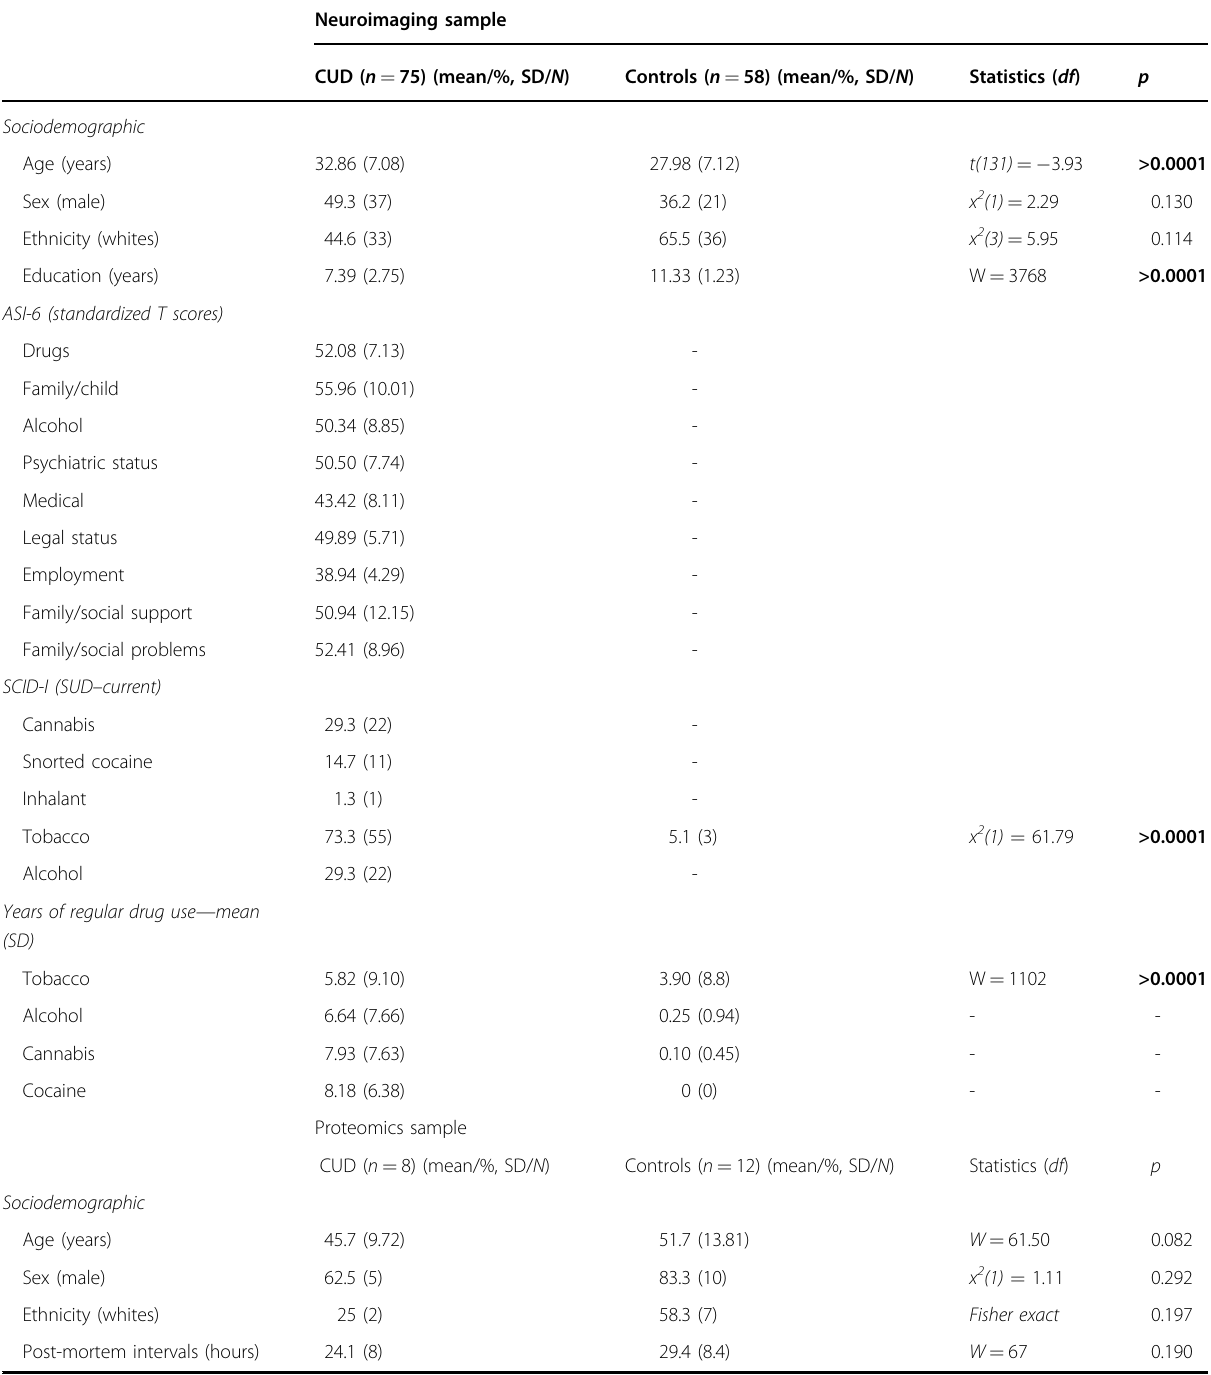
Table 1 Sociodemographic and clinical characteristics of the samples. Neuroimaging